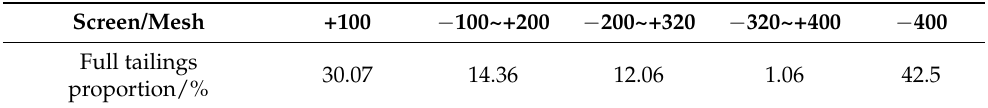
Table 1. Tailings grain